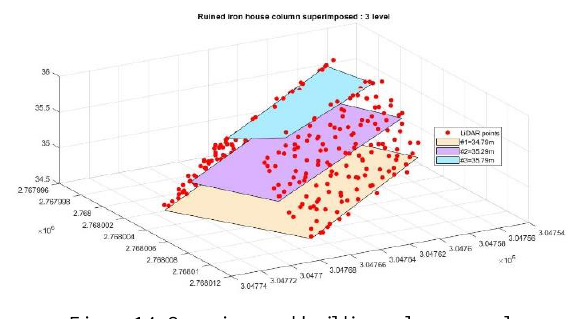
Figure 14. Superimposed building column sample Table 2. Data amount after column superimposition